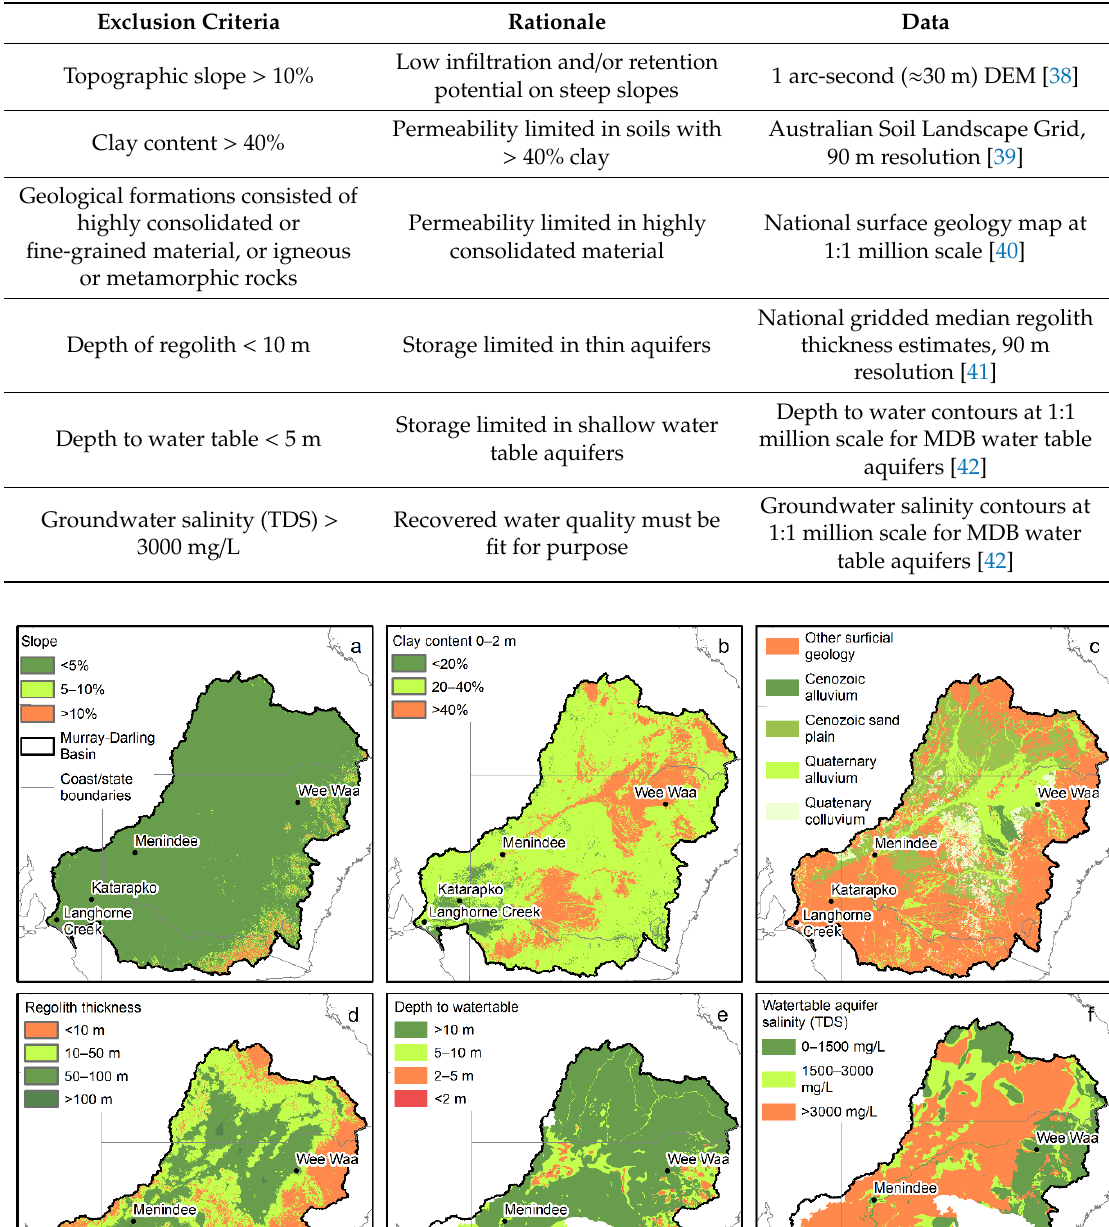
Table 1. Regional aquifer storage assessment criteria, rationale, and data sources.